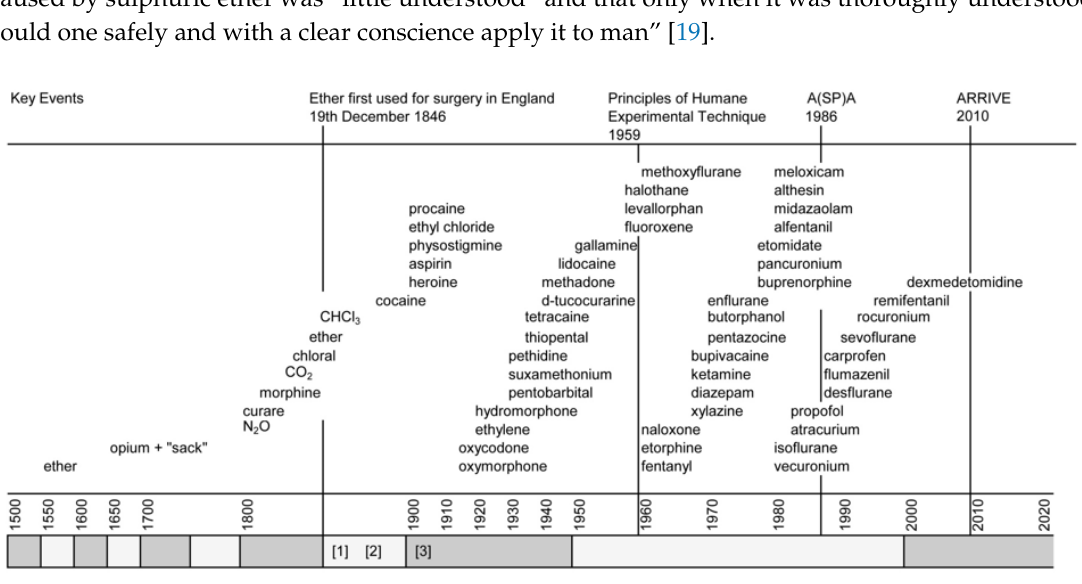
Figure 1. Dates of anaesthetic and analgesic drug discoveries in relation to key events in the refinement of animal experimentation. Alternatively shaded x axis blocks each represent a 50 year epoc.